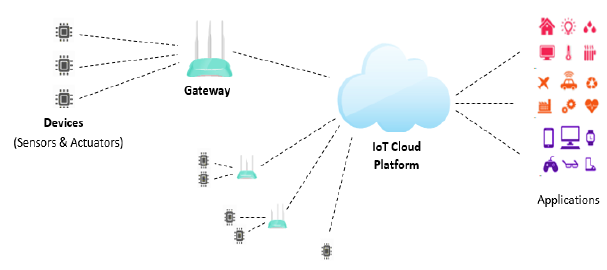
Figure 4. IoT solutions architecture